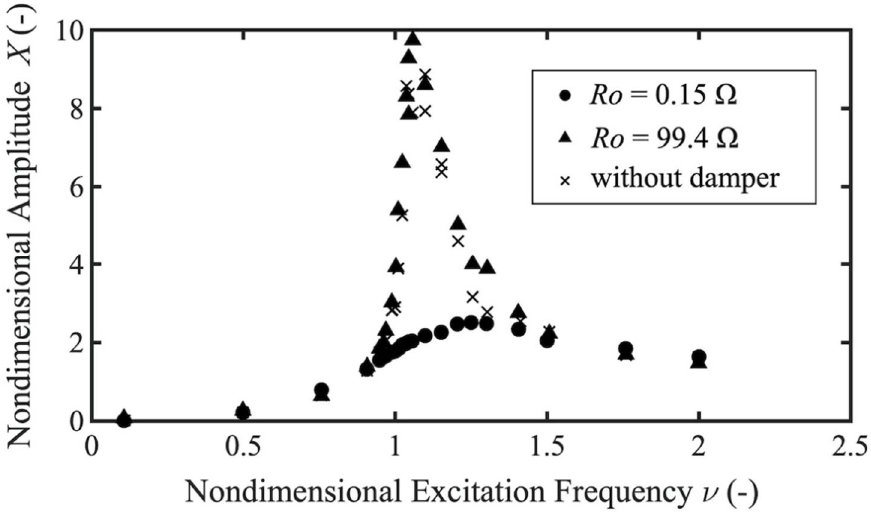
Figure 5. Frequency response plots of the vibration amplitude of the permanent magnet obtained by experiments with the series type shunt damper.